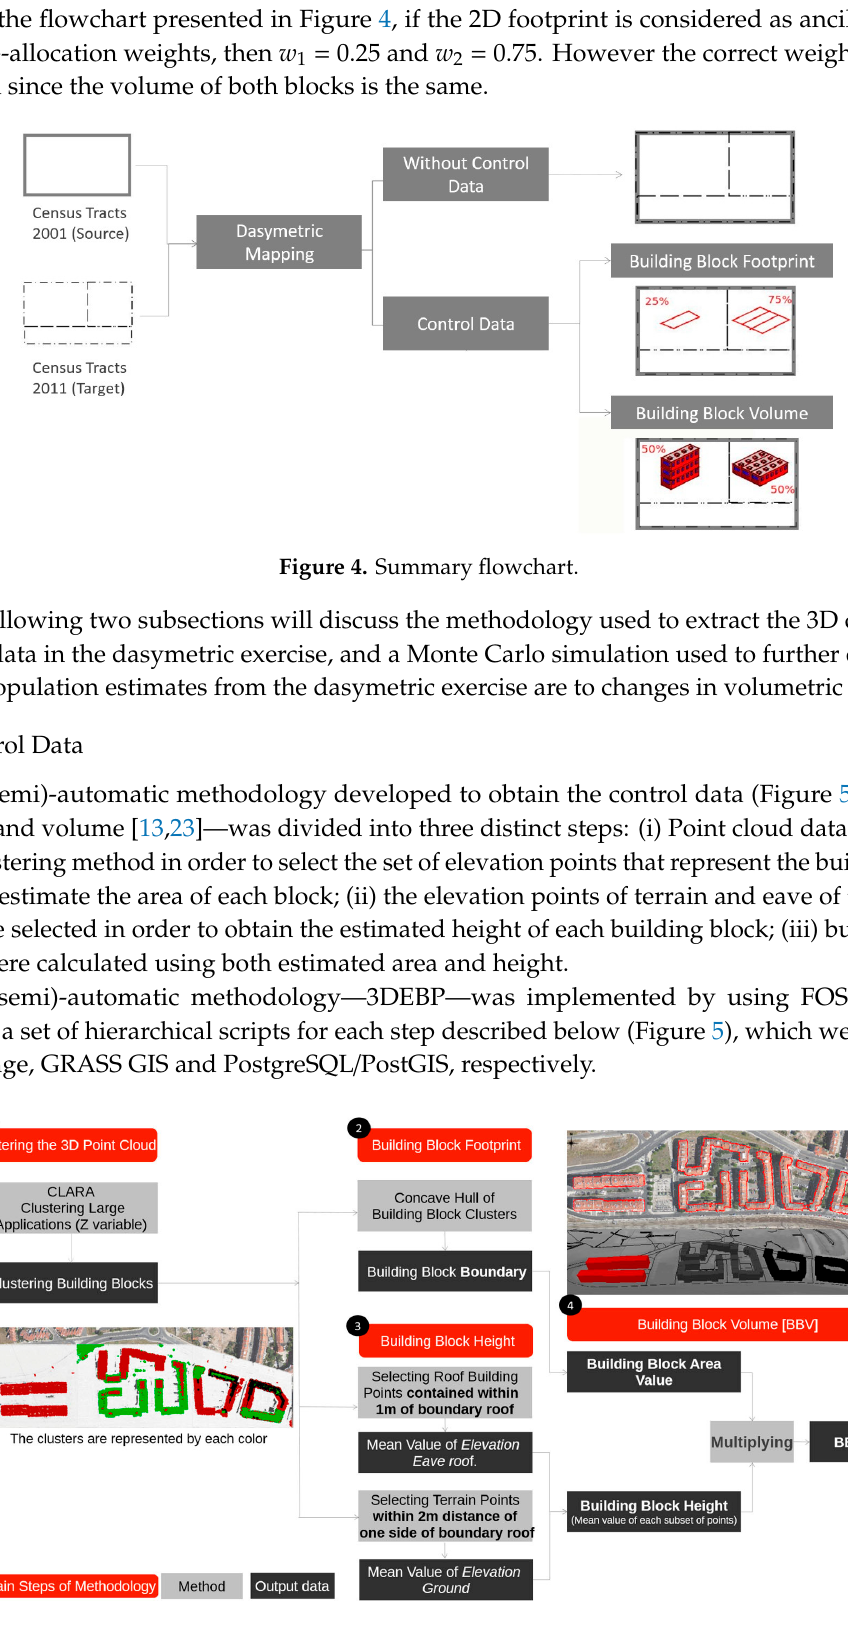
Figure 5. Methodological approach to building block volume extraction—3DEBP—based on a 3D Point